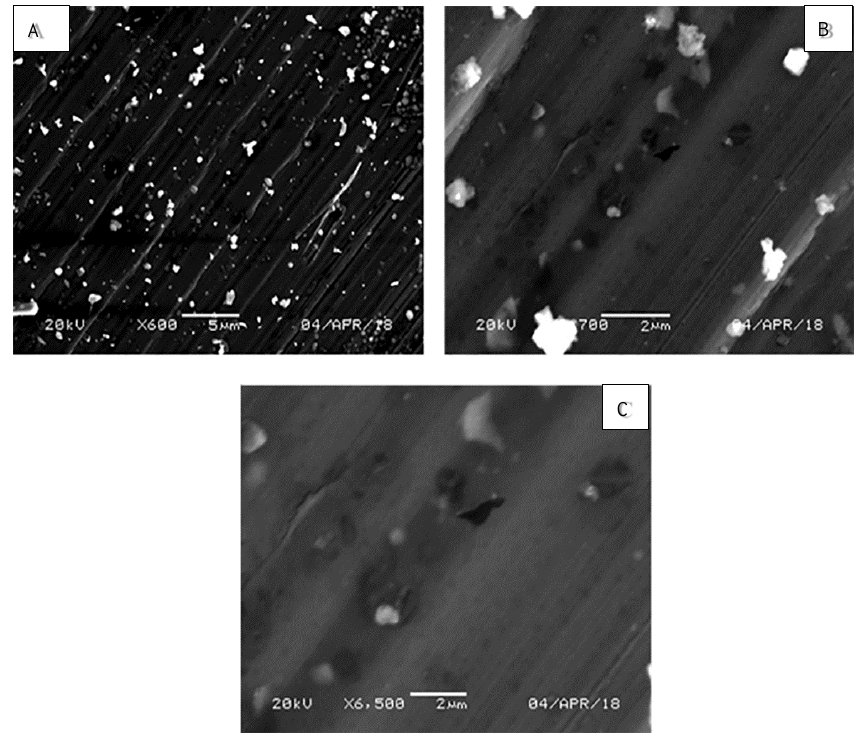
Figure 1. Morphology of PMMA/3 wt. % TiO 2 nanocomposites at different magnifications ( A ) X600, ( B ) X2700 and ( C ) X6500.